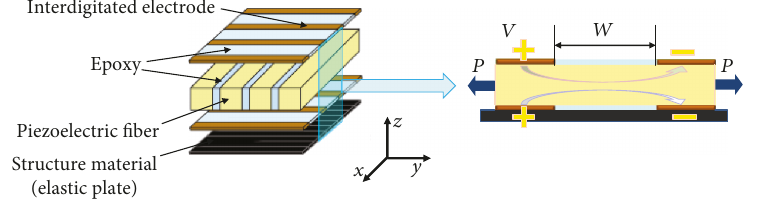
Figure 1: Structure and driving model of MFC.